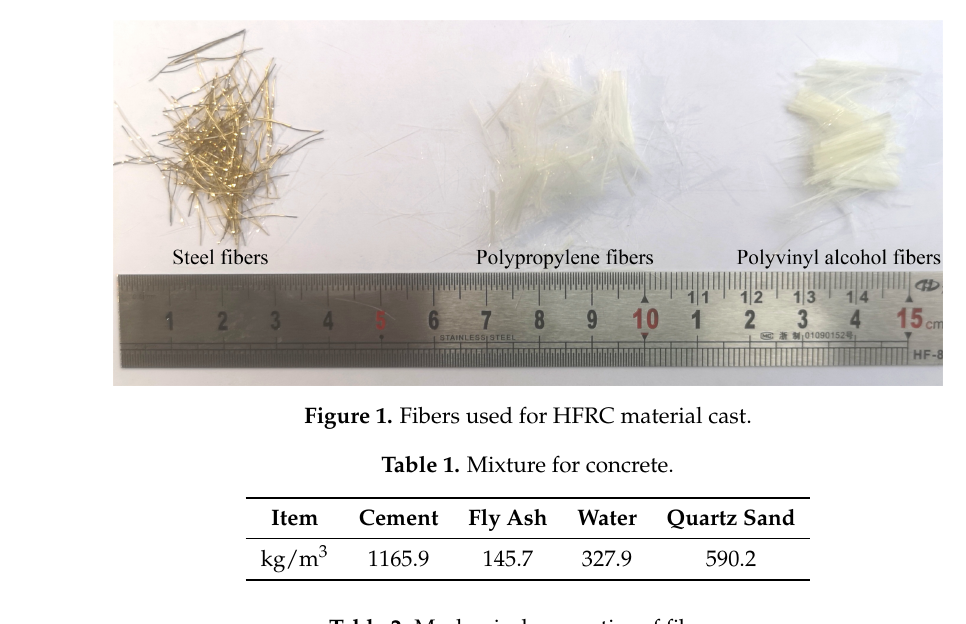
Table 2. Mechanical properties of fibers.